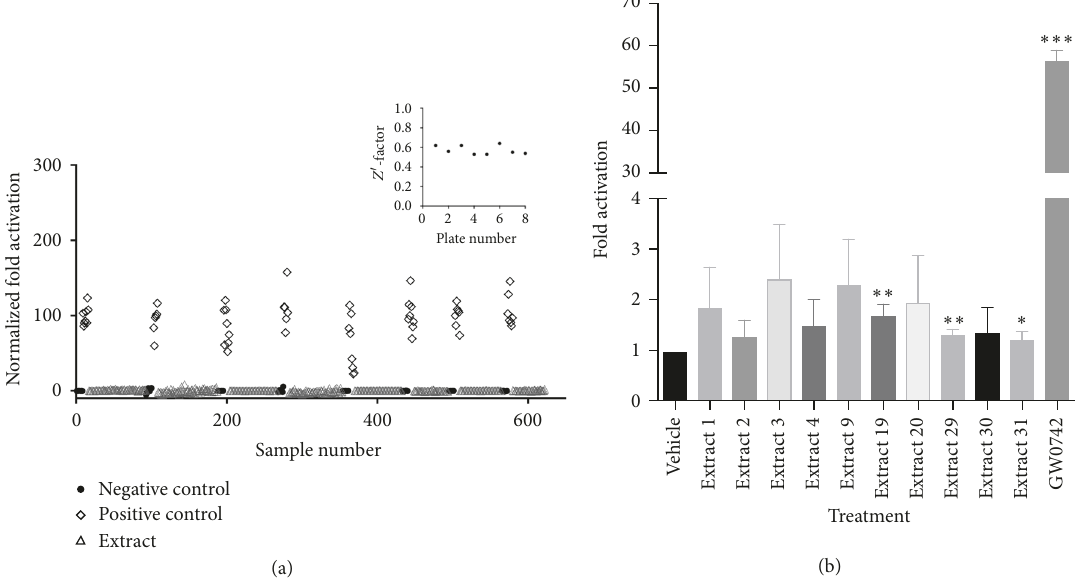
Figure 4: High-throughput screening assay and statistics. (a) HTS results are expressed by the firefly/Renilla ratio of each compound normalized by positive and negative controls, which were set as 100% and 0%, respectively, for each plate. It is possible to observe that the positivecontrolvariedamongdifferentplatesandwells.DespitethefactthatthesearchedextractspresentedlowPPARß/ 𝛿 activation,theystill presented significant differences in comparison to the negative controls (signal 7 times higher than the negative control standard deviation) . Insert: 𝑍 󸀠 values for each screened plate presented the high reliability of the data. (b) Confirmatory transactivation assay in triplicate using the possible hit candidates from the previously screened Phytobios library with 1 𝜇 M GW0742 as the positive control, 1% DMSO as the negative control (vehicle), and 0.01 mg/mL of the tested extracts. We considered confirmed hit candidate extracts that showed firefly/Renilla ratios seven times higher than the standard deviation ( > 7 × DP) for the negative control treatment for at least two of the three replicates. Data are the mean ± SD. 𝑝 values were calculated by the unpaired 𝑡 -test ( ∗ 𝑝 < 0.05 , ∗∗ 𝑝 < 0.01 , and ∗∗∗ 𝑝 < 0.001 ) with GraphPad